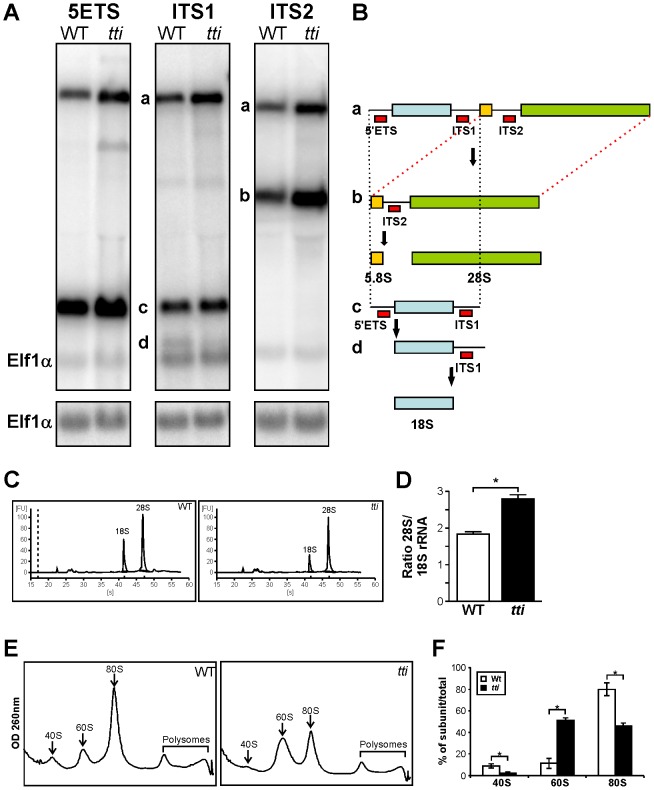

ttis450 larvae display defects in ribosome biogenesis.(A) Northern analysis of RNA isolated from WT and ttis450 larvae at 120 hpf using 5′ETS, ITS1, and ITS2 probes to detect precursor forms of rRNA. Elf1α is a loading control. a–d correspond to the rRNA intermediates depicted in Figure 3B. (B) Schematic diagram showing the rRNA processing pathway in zebrafish [60]. The sites of hybridization of the 5′ETS, ITS1 and ITS2 probes are indicated. (C) Representative E-Bioanalyser analysis of total RNA isolated from WT and ttis450 larvae at 120 hpf demonstrates a reduction in the 18S peak in ttis450 larvae resulting in an elevated 28S/18S rRNA ratio in ttis450 (D). Graphical representation of the experiment shown in C. Data are represented as mean +/− SD (n = 5). (E) Representative polysome fractionation analysis performed on WT and ttis450 larvae at 96 hpf demonstrates reduced levels of 40S ribosomal subunits and 80S monosomes and an increase in free 60S subunits in ttis450 larvae compared to WT. (F) Graphical representation of the experiment shown in E. Data are represented as mean +/− SD (n = 5) *p<0.05.